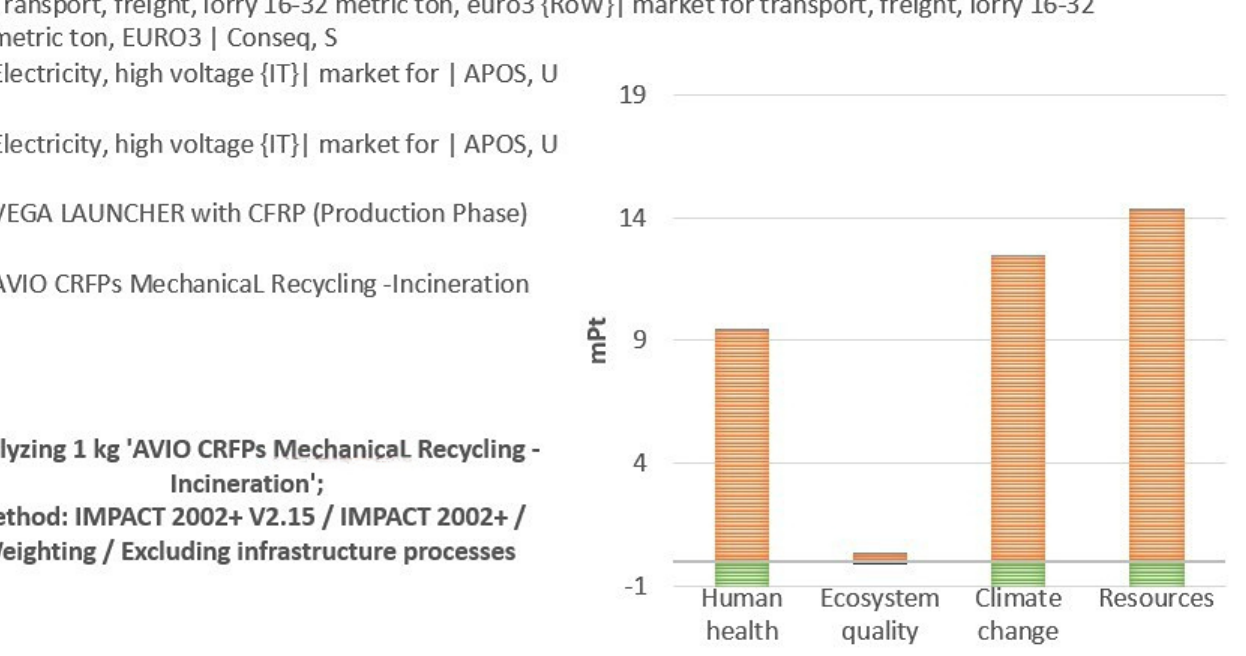
Figure 16. Results of Mechanical recycling with incineration into Endpoint categories.